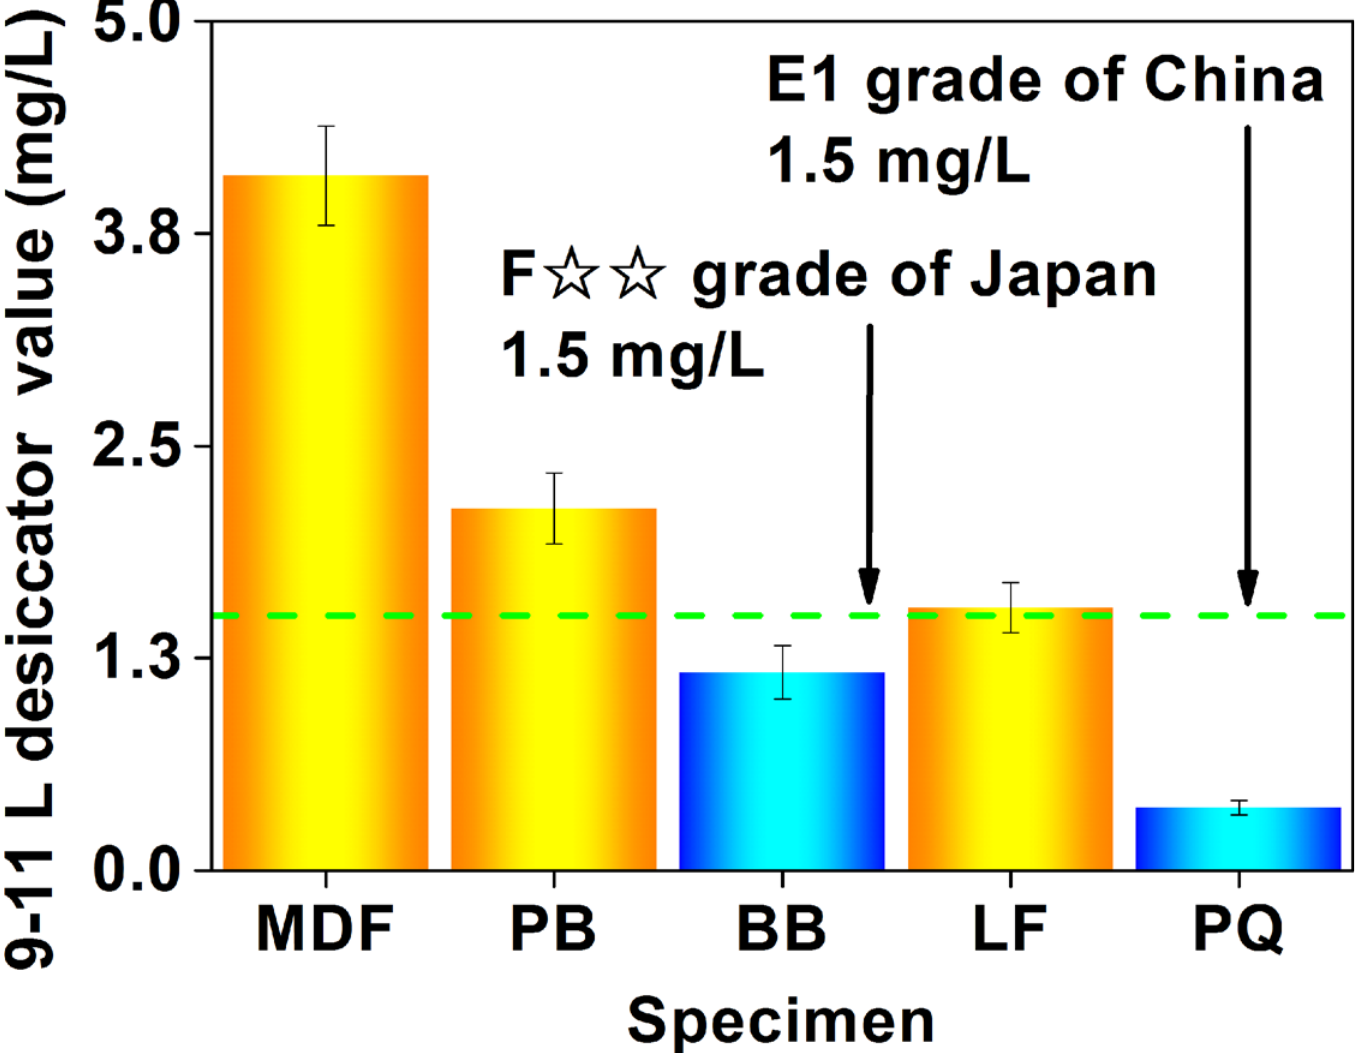
Fig 3. Formaldehyde emission values (9 – 11 L desiccator value) of various materials characterized by the 9 – 11 L desiccator method of the Chinese national standard GB 18580. MDF, medium density fiberboard; PB, particleboard; BB, blockboard; LF, laminate flooring; PQ, parquet.